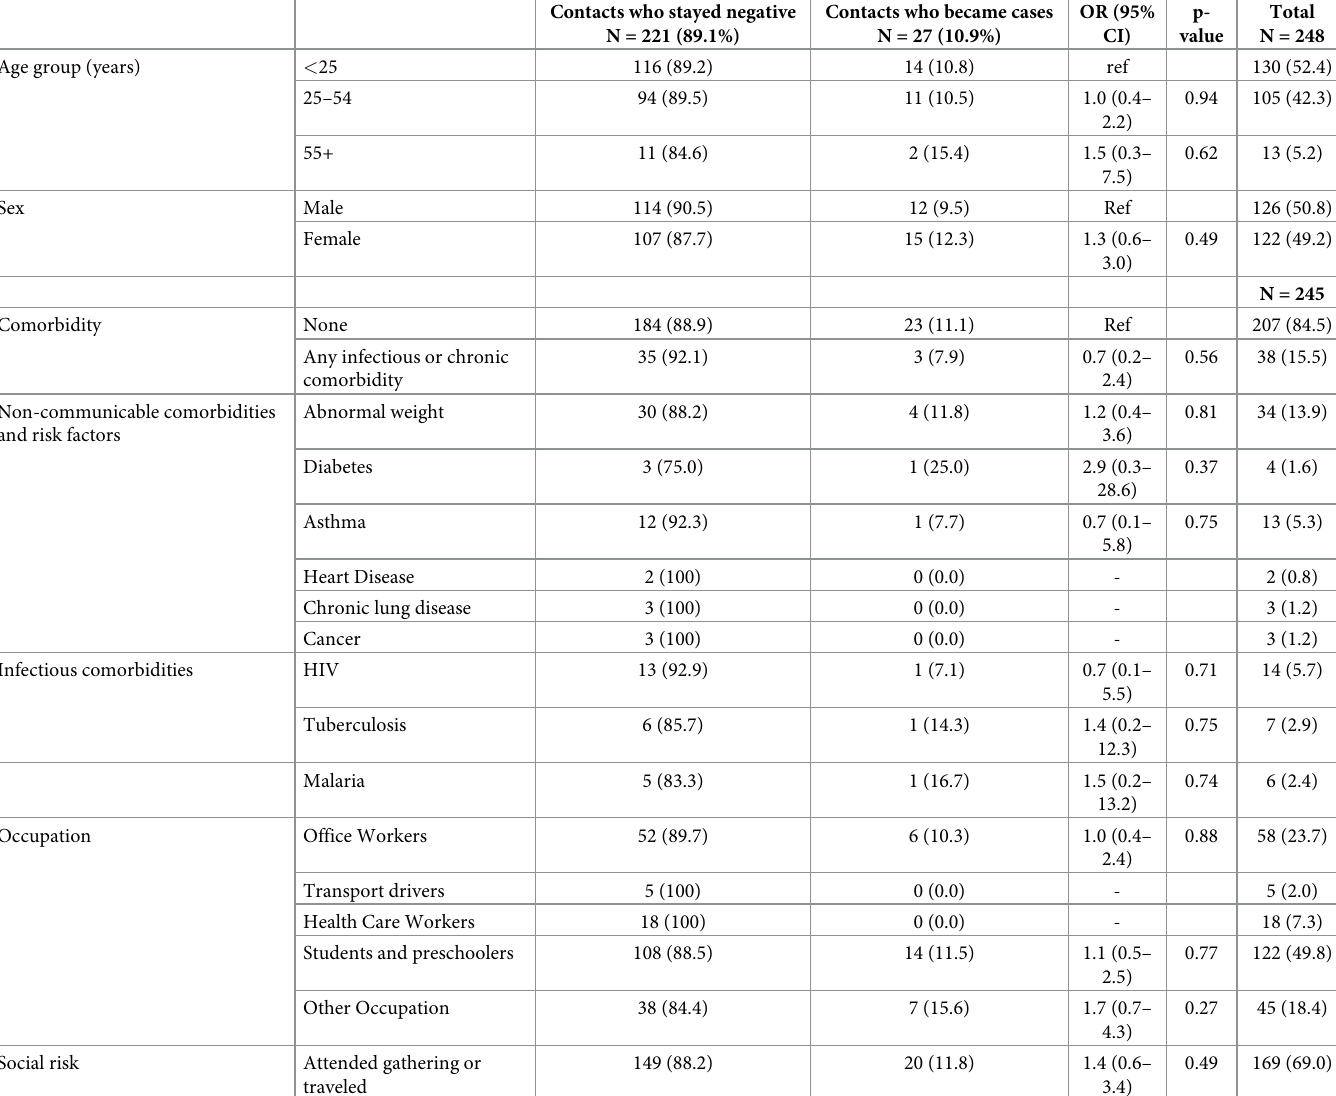
Table 4. Risks associated with acquiring COVID-19 infection in Contacts, FFX study, Kisumu, Kenya, June-October